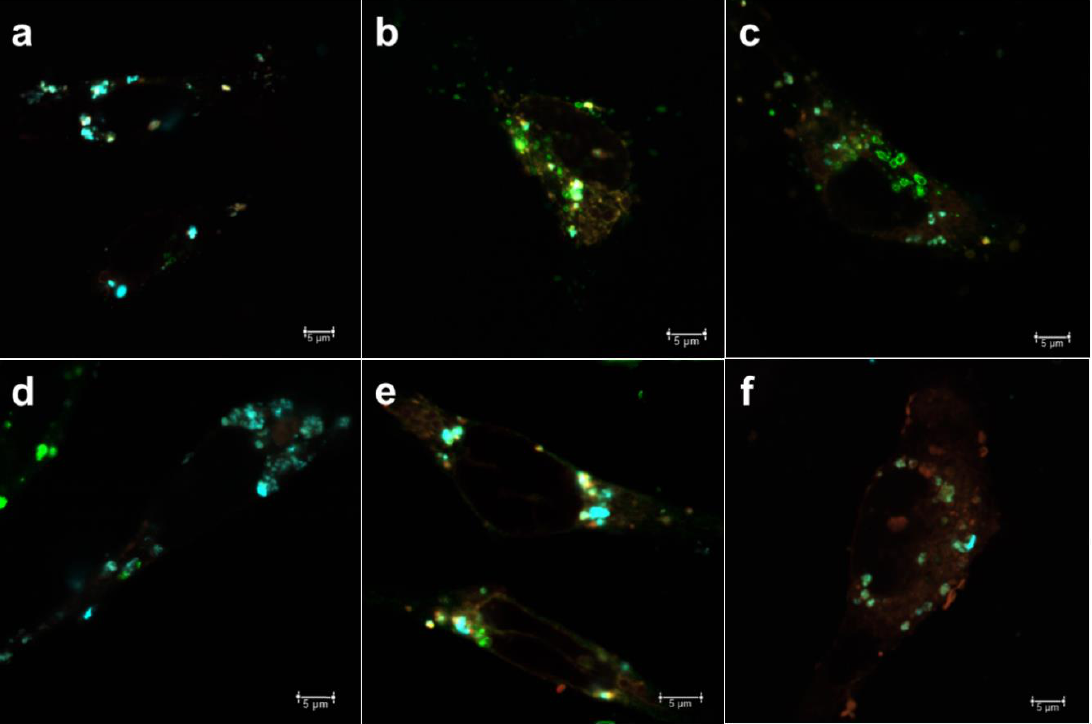
Figure 4. MSNs (cyan) loaded with DiD (red) and endosomal markers (green) ( a – c ) EEA1 (0.1, 0.5, 1.0 wt % loading of DiD, respectively) and ( d – f ) Rab7 (0.1, 0.5, 1.0 wt % loading of DiD, respectively) at 48 h.